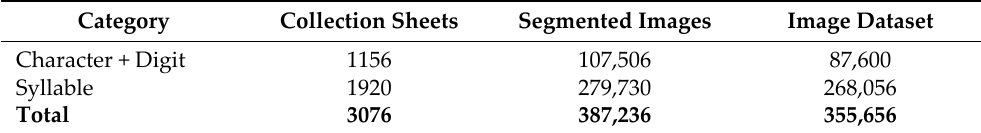
Table 2. The statistics of raw, segmented, and current data of Burapha‑TH Dataset.